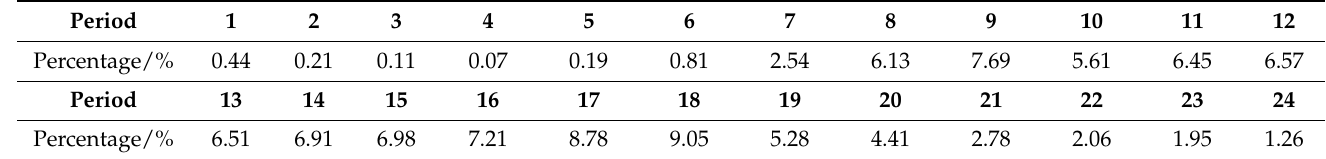
Table A1. Percentage of EV mileage in each period to daily mileage.